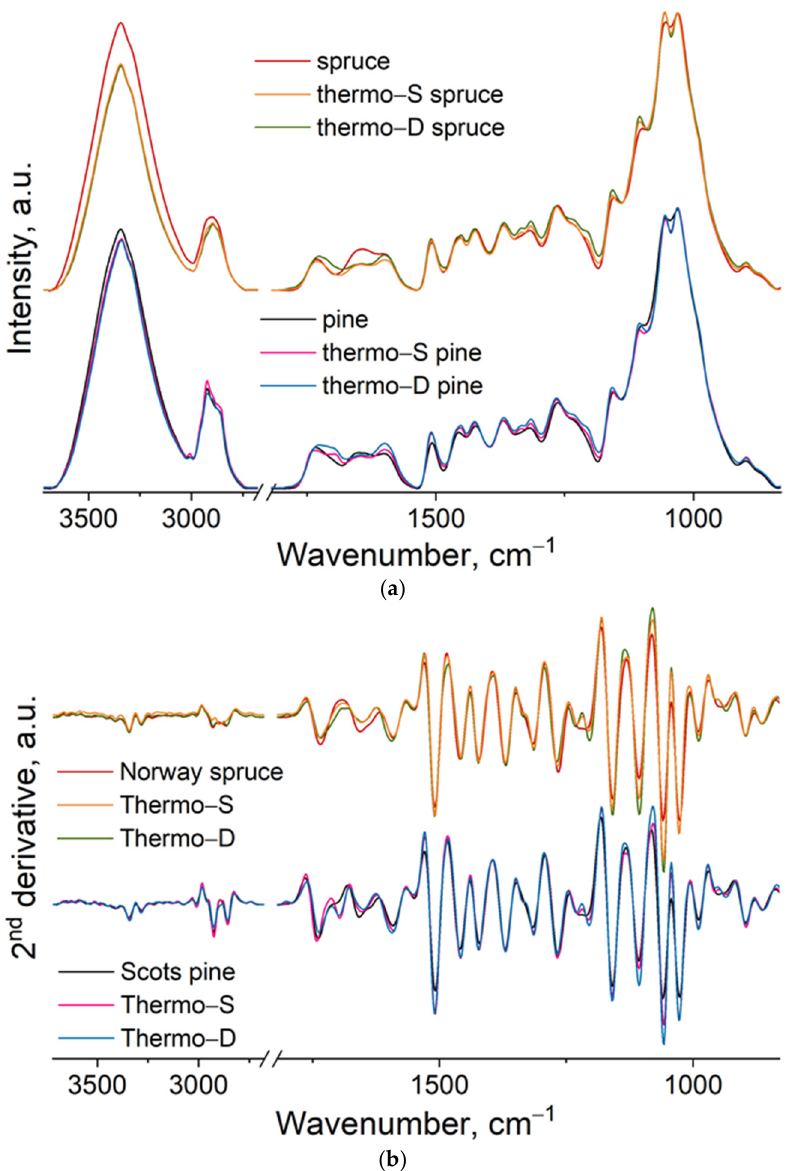
Figure 1. Average infrared spectra ( a ) and their second derivatives ( b ) of the untreated and ThermoWood ® Norway spruce and Scots